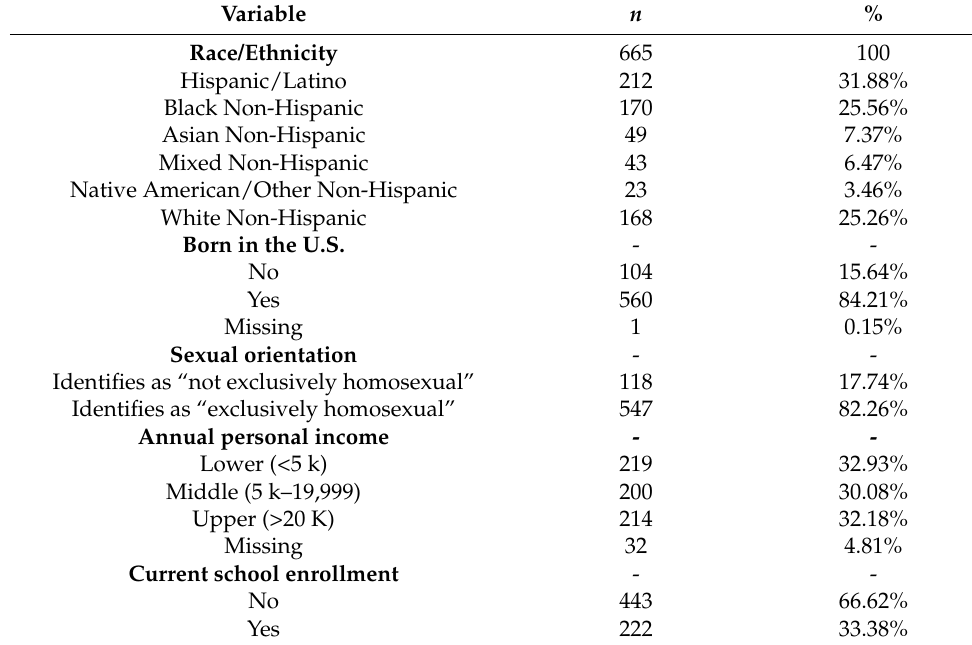
Table 1. Characteristics of P18 Cohort Study participants from baseline Wave II sample ( n = 665).